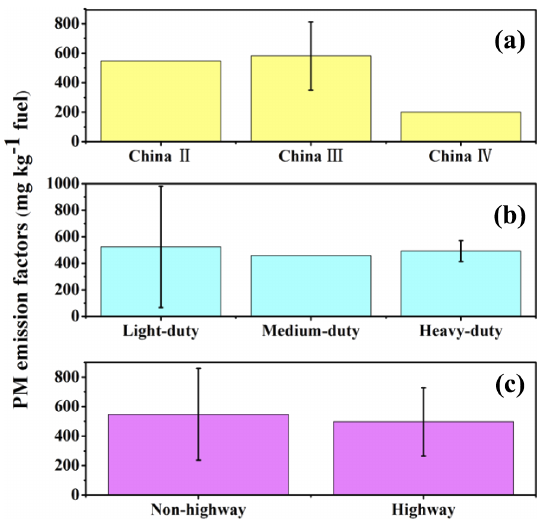
Figure 4. Diesel trucks EF PM for different emission standards (a) , vehicle sizes (b) , and driving conditions (c)